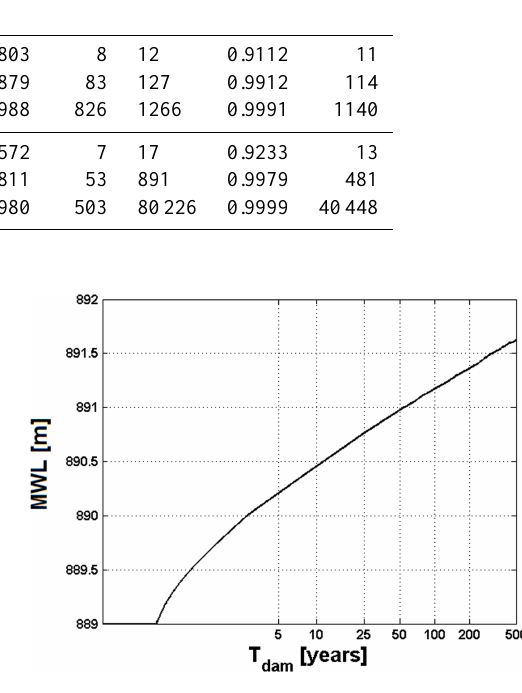
Fig. 9. Frequency curve of MWL for the spillway real set-up ( E =889m, L